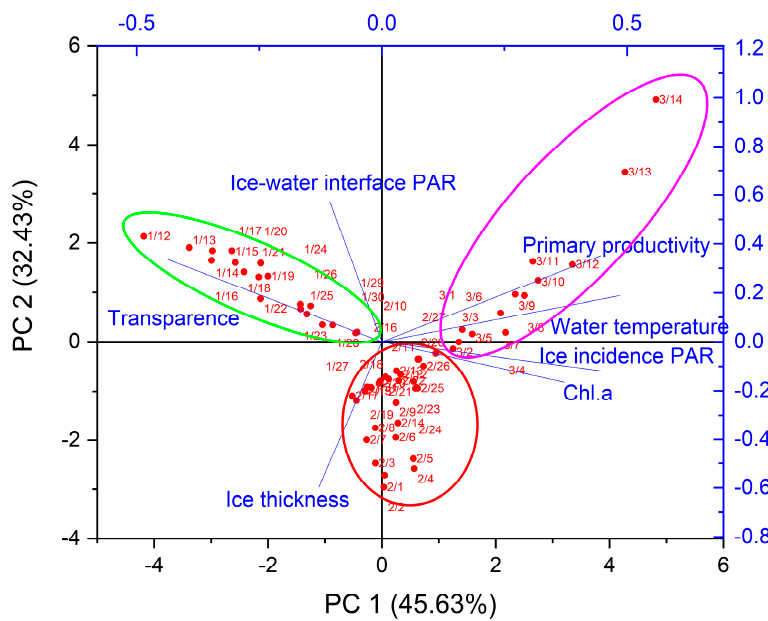
Figure 4. Principal component analysis of primary productivity and affecting factors in the VGPM model.